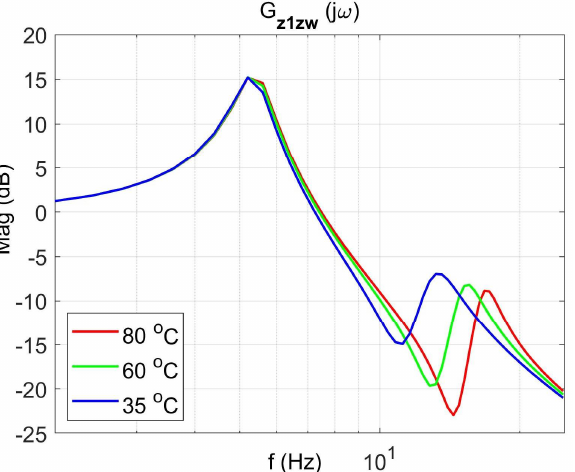
Figure 9. The phase shift of protected mass as a function of frequency and temperature, the transfer function G z 1 zw .